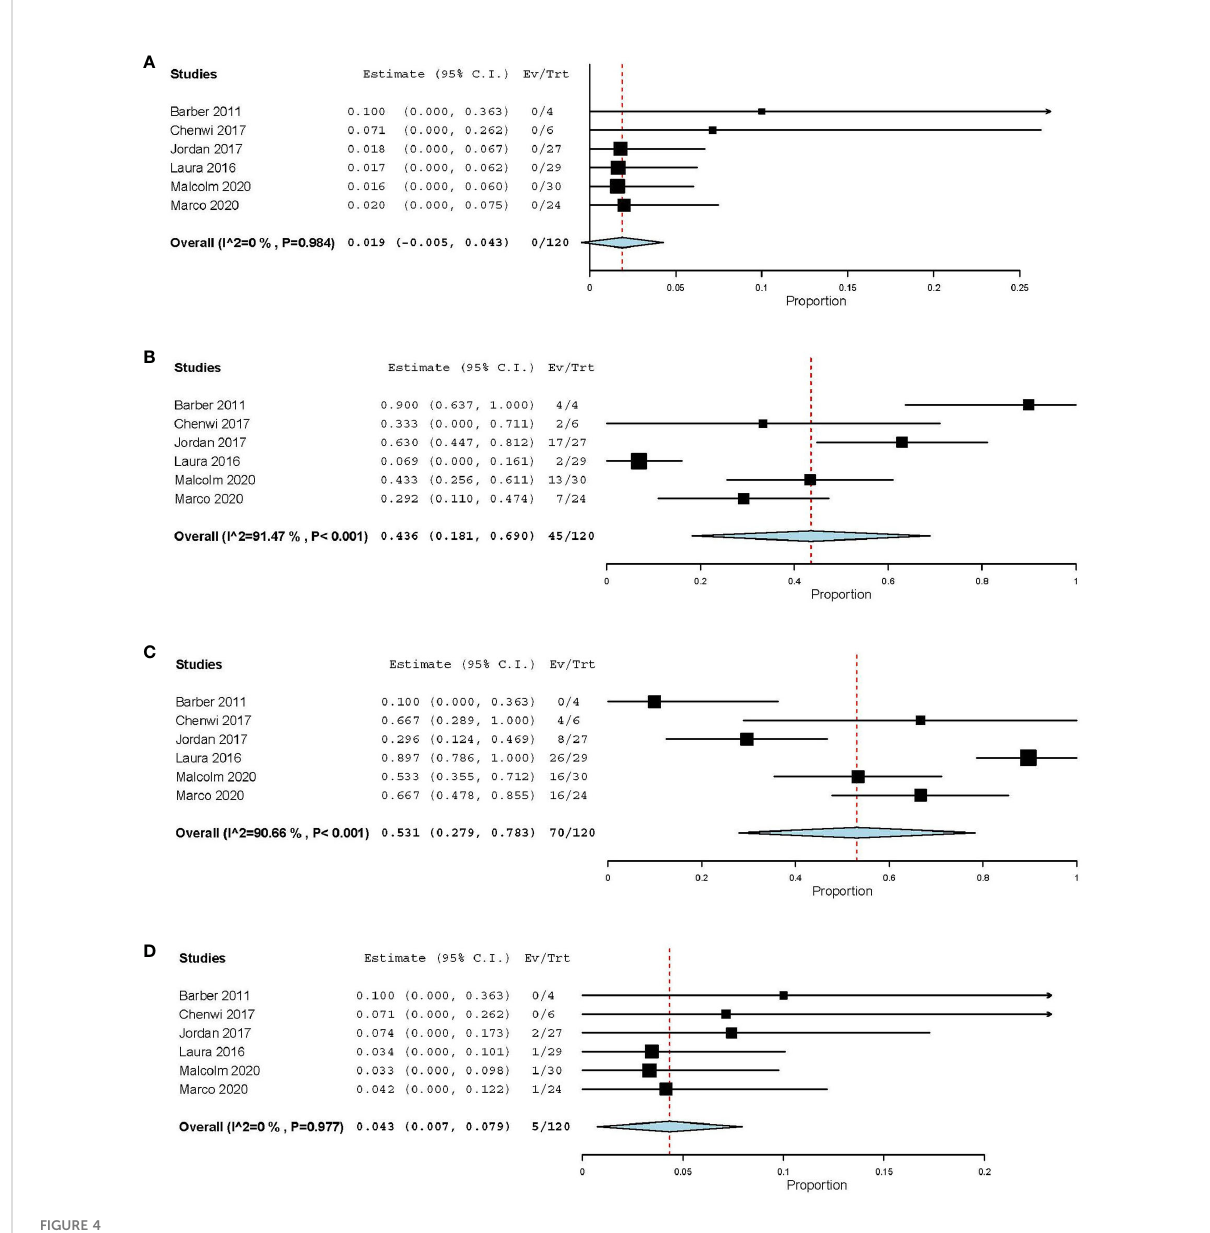
FIGURE 4 Estimate the rate of CR (A) , PR (B) , SD (C) , PD (D) of different